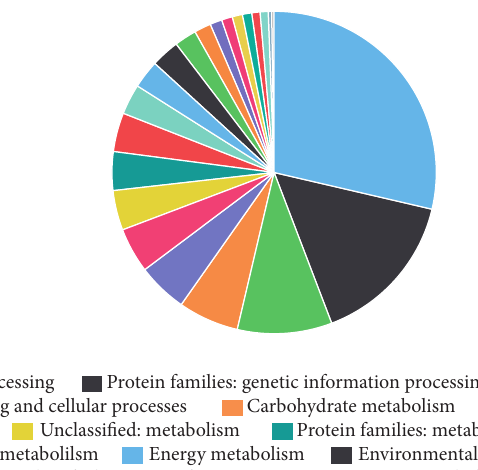
Figure 3: The functional predictions of proteins encoded in the genomes of MAG I.I.